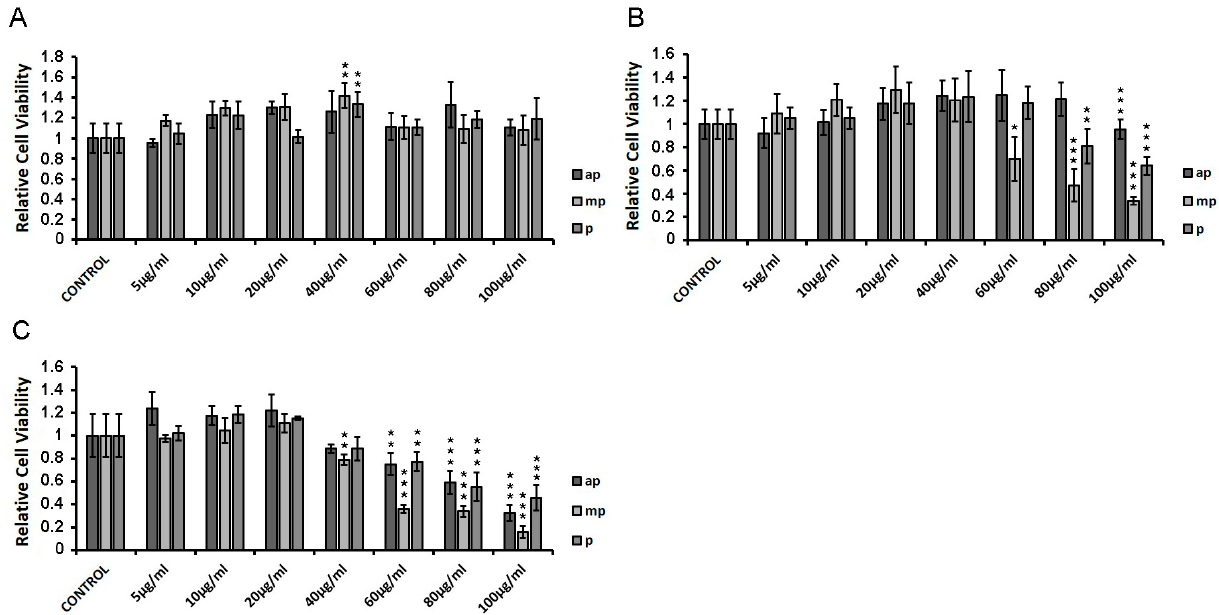
Figure 2. HEK293 cell viability measurement in the presence of Chios Mastiha apolar (ap), medium- polar (mp), and polar (p) fractions, upon 6 h ( A ), 24 h ( B ), and 48 h ( C ) treatment. Cell viability was evaluated by MTT assay. DMSO (1:1000) was added in control condition. Relative cell viability is expressed as the viability of the cells treated with the respective resin fractions compared to the cell viability of the DMSO-treated cells. Cell viability of control cells was set at 1. Data are expressed as the mean ± SD, (n = 3–9), * p < 0.05; ** p < 0.01; *** p < 0.001.